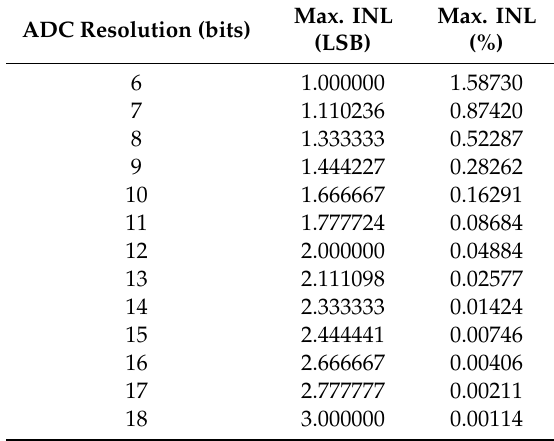
Table 2. Max. INL in LSBs and in the percentage of the full-scale (for all output codes and gain correction coe ffi cients) simulated as a function of the ADC